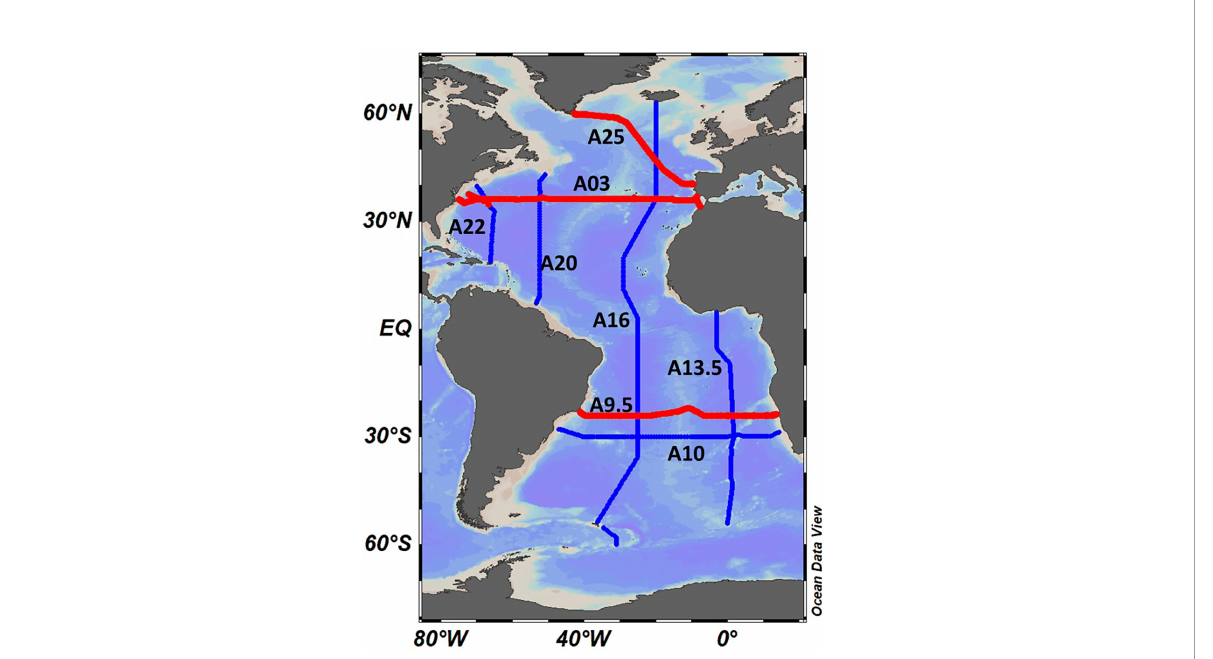
FIGURE 1 Location of the sections included in the PANGAEA database (A16, A20, A22, A10 and A13.5, in blue) and three extra sections (A9.5, A25 and A03, in red) used in this study to test the model. Figure plotted with the Ocean Data View software (Schlitzer,